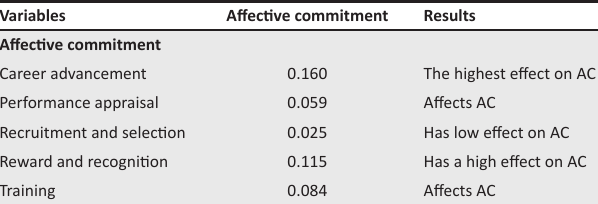
TABLE 5: Summary of f 2